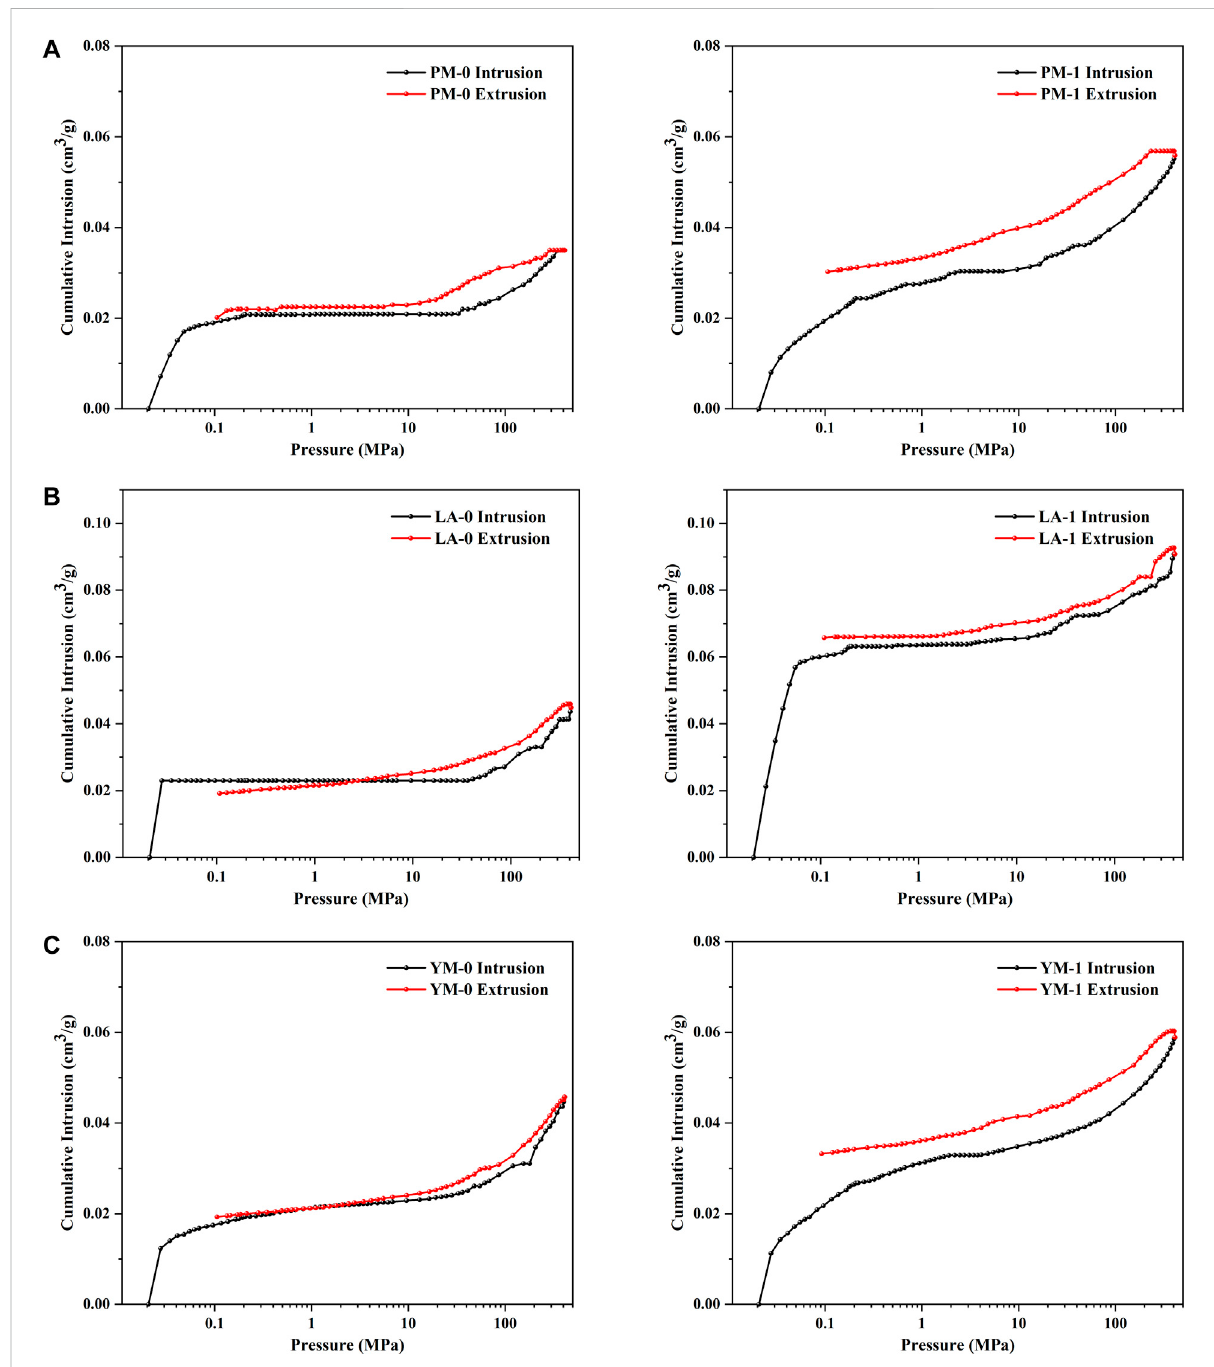
FIGURE 5 The MIP intrusive and extrusive curves of the raw and acidi fi ed coal samples: (A) PM; (B) LA; (C)